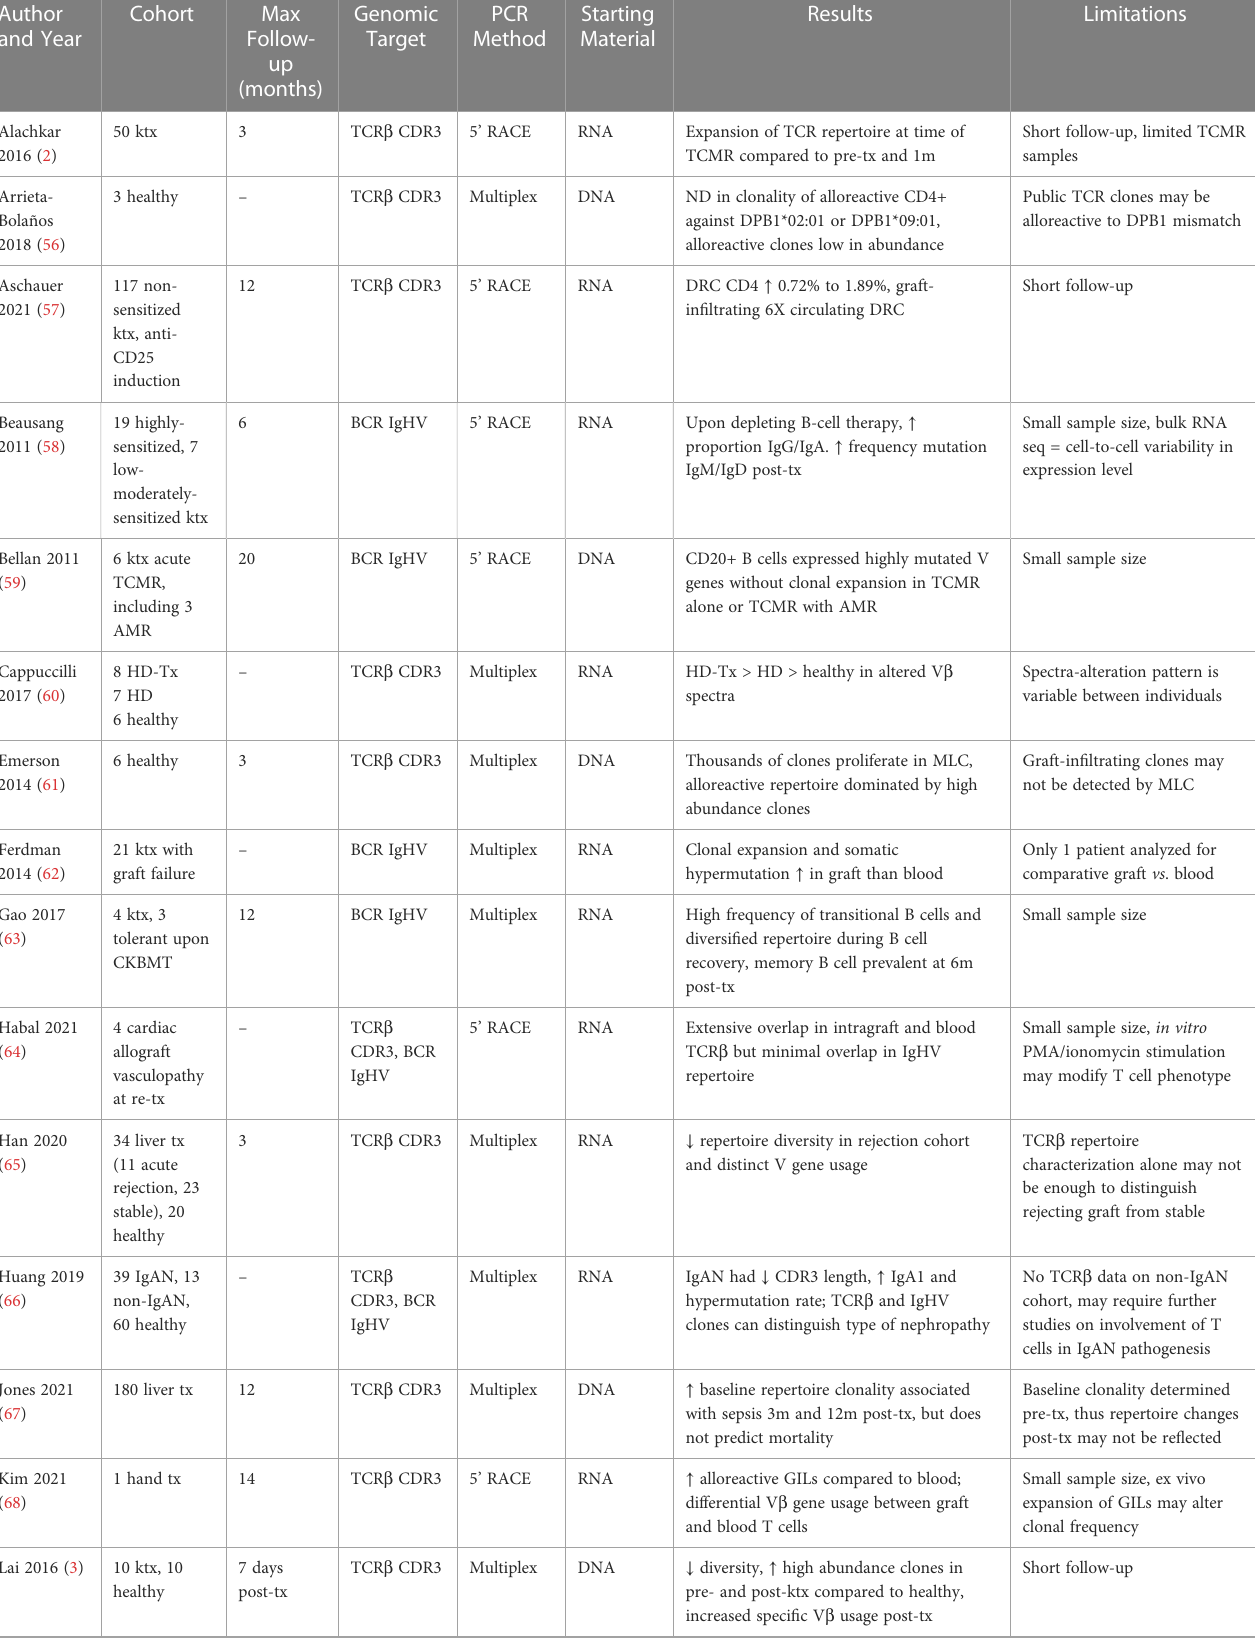
TABLE 2 Summary of fi ndings, methodology and demographic characteristics of included